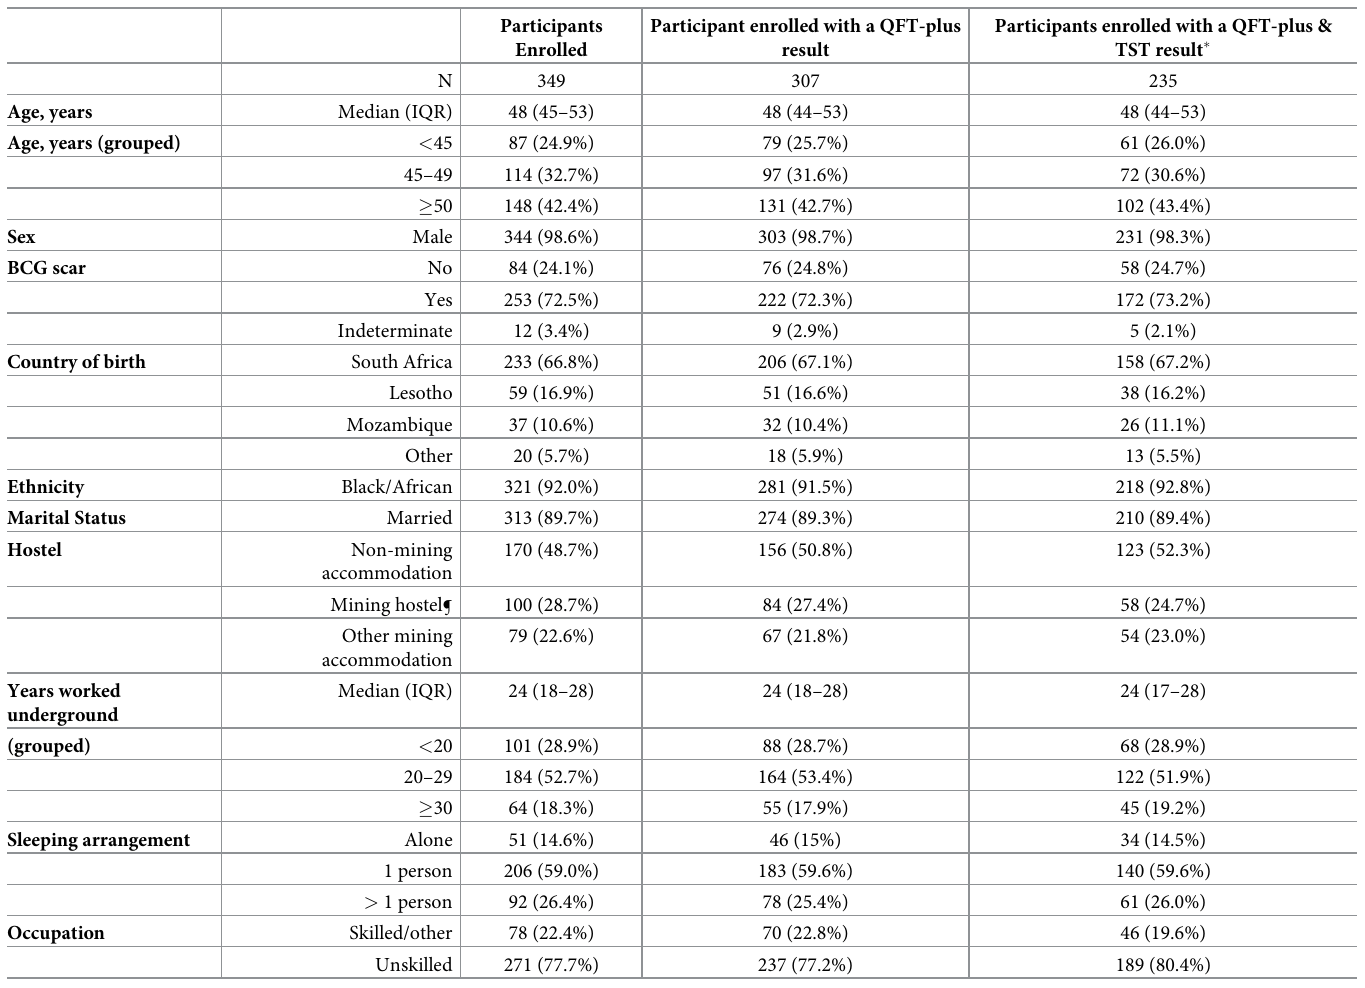
Table 1. Baseline demographic